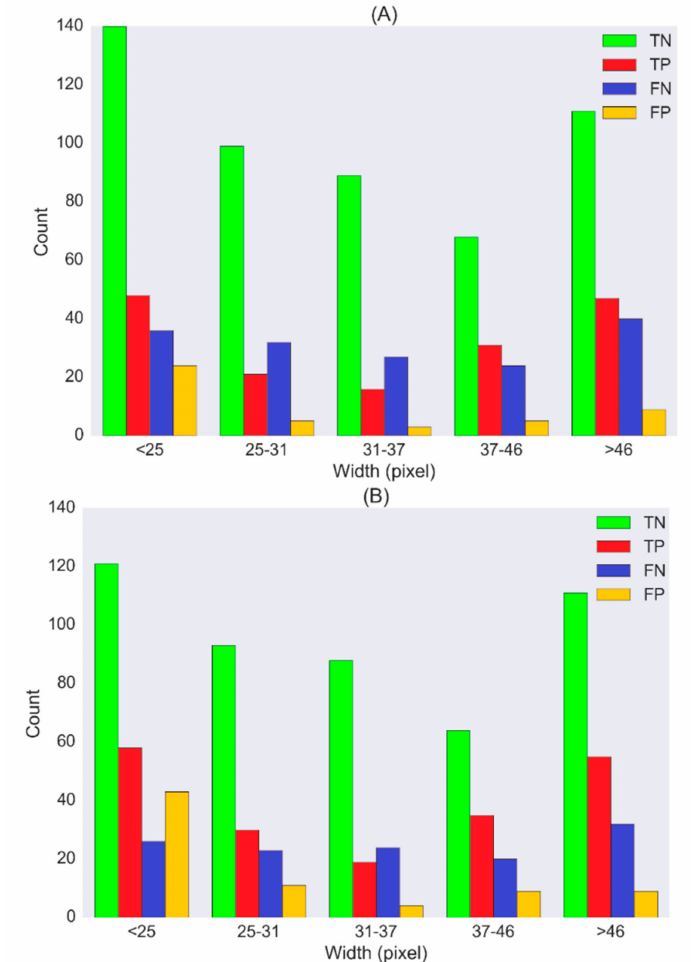
Figure 10. Plots of the confusion matrix values obtained using re-classified test B dataset: ( A ) CNN ( B ) Balanced-CNN. FP (non-collapsed buildings misclassified as collapsed ones); FN (collapsed buildings misclassified as non-collapsed ones); TP (collapsed buildings classified correctly); TN (non-collapsed buildings classified